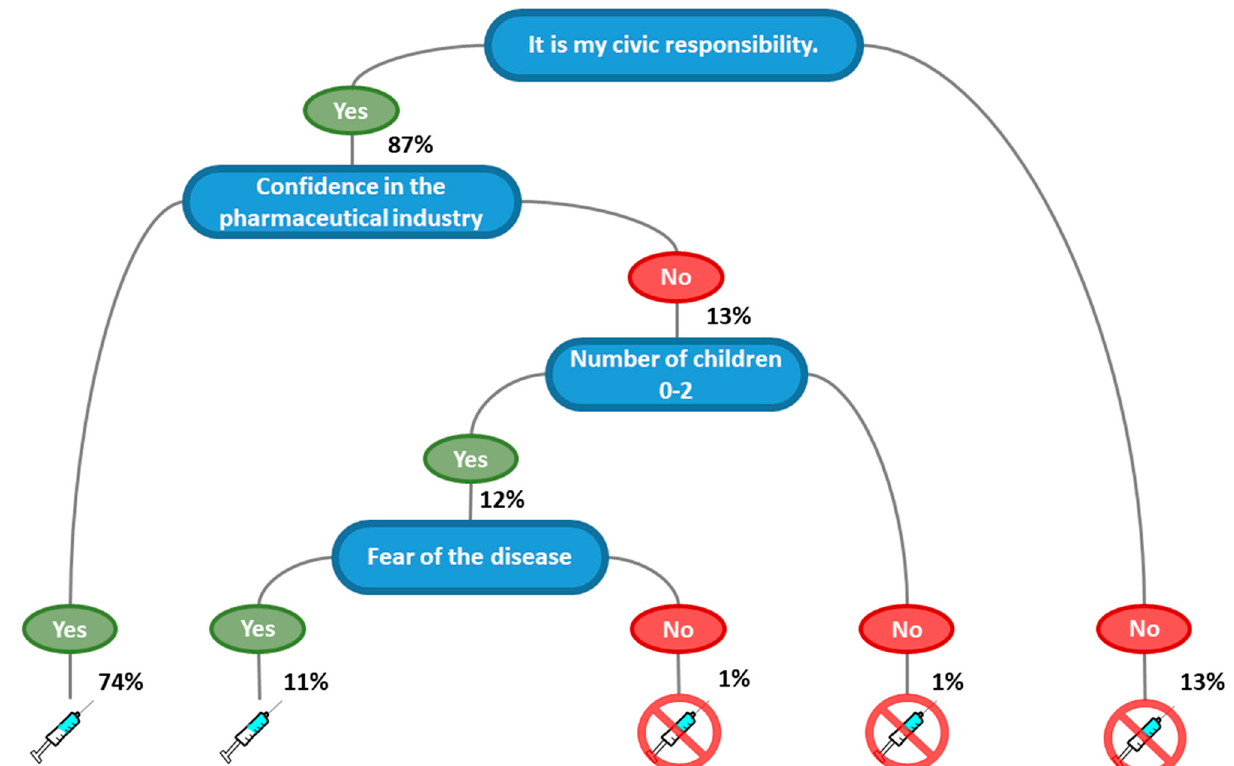
Figure 3. Decision tree for taking the COVID-19 vaccine based on stepwise logistic regression. We proceeded to predict the performance of models 1, 2, and 3 (Table 5) by having the models learn on 90% of the answer sets and then tested the learned models on the remaining 10%. Model 1 (fully adjusted) enabled predicting the intent to get the vaccine with an accuracy of 82.25%, model 2 with an accuracy of 84.84%, and model 3 with an accuracy of 87.45%. Table 5. Univariate crude and adjusted logistic regression models for odds ratio of intent to take the COVID-19 vaccine.